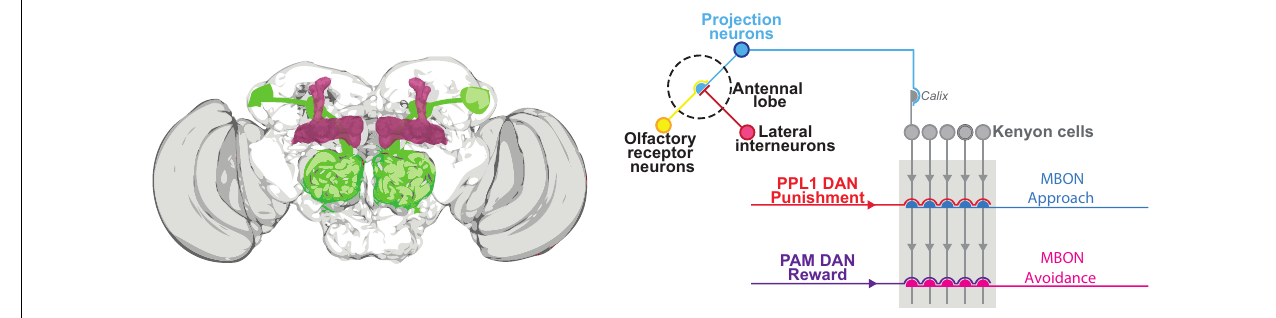
FIGURE 1 | Simplified schematic of the olfactory memory circuit. Left. Drosophila brain schematic showing the PN in green and MB lobes in red. Right: the olfactory stimulus is initially detected by one (or multiple) olfactory receptor neurons (ORN) depending on the odorant. The signal is then transmitted to the PN at antennal lobe level. The ORN-PN synapse is modulated by a local interneuron, which is often inhibitory. The PN then synapse onto the KC in a neuropil region called calyx. All together KC axons form a macro-structure called mushroom bodies (MB), which are considered the main center for associative memory. Two different neuronal types establish connections with the MB: Dopaminergic neurons (DAN) and the MB Output Neurons (MBON). DAN drive plasticity onto the KC and are divided into two classes: the paired posterior lateral 1(PPL1) cluster, which encodes punishment, and the protocerebral anterior medial (PAM) cluster, which encodes reward. The MBON mediate the behavioral response which can be either approach or avoidance. During memory encoding, either the aversive or appetitive circuits are activated. In a simplified model, if the learned stimulus is aversive, PPL1-punishment neurons are activated causing plasticity at the MB-MBON (blue) synapse. Plasticity reduces the activity of the blue-MBON which mediate for approach; while the MBON that mediate avoidance (pink), is activated at the same intensity, causing an avoidance behavior. On the other hand, if the learned stimulus is appetitive PAM-reward neurons are activated causing plasticity onto the MB-MBON (pink) synapse. Plasticity reduces the activity of pink-MBON, which mediate avoidance; while the MBON, that mediate approach (blue), is activated at the same intensity, causing an approach behavior. In the interest of simplicity, other important neurons contributing to the MB circuit are